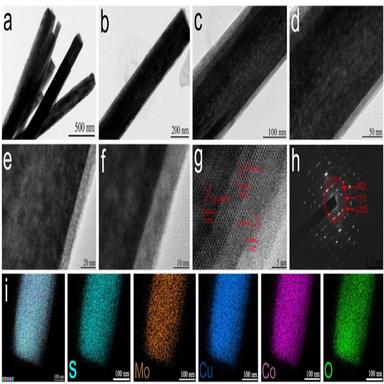
XRD patterns of CuCo2S4 and CuCo2S4@CoMoO4 compounds.